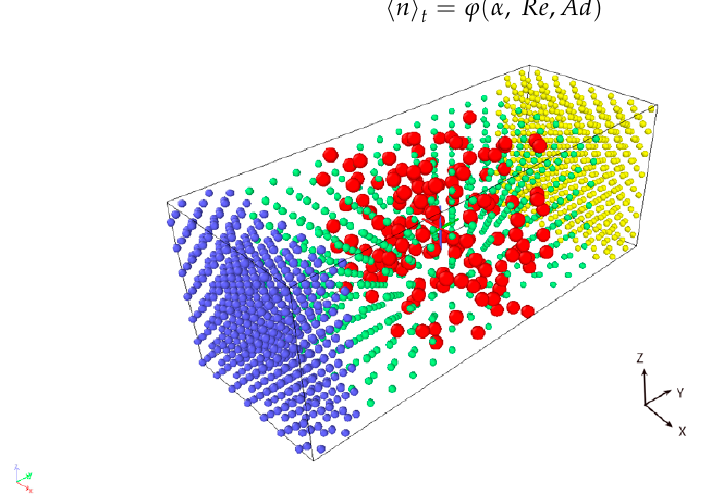
Figure 1. Geometry of the system and initial status (time = 0). Four particle types are coloured. The top wall (yellow, constant velocity U along x direction) and bottom wall (blue, stationary) generated a simple shear flow. Solid particles (red) were randomly located within the fluid (green) domain based on their volume fractions.